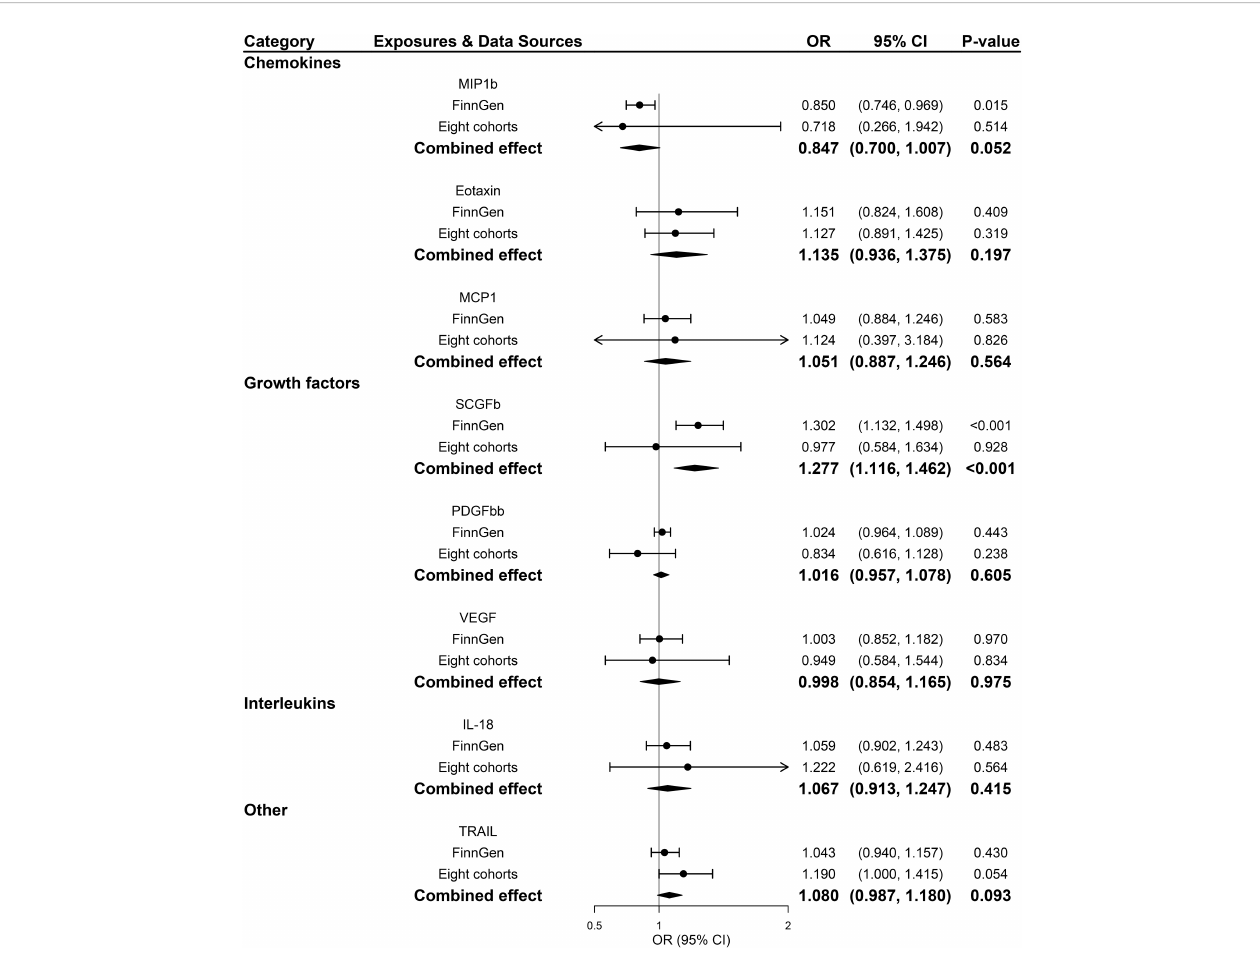
FIGURE 2 Associations between genetically predicted systemic in fl ammatory regulators and proliferative diabetic retinopathy (with genome-wide signi fi cant SNPs). IL, interleukin; MCP1, monocyte chemotactic protein-1; MIP1b, macrophage in fl ammatory protein-1 beta; PDGFbb, platelet-derived growth factor BB; SCGFb, stem cell growth factor beta; SNPs, single-nucleotide polymorphisms; TRAIL, TNF-related apoptosis-inducing ligand; VEGF, vascular endothelial growth